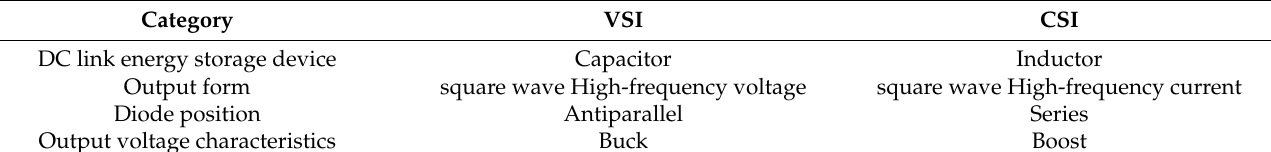
Table 2. The comparison of performance and structure between VSI and CSI.